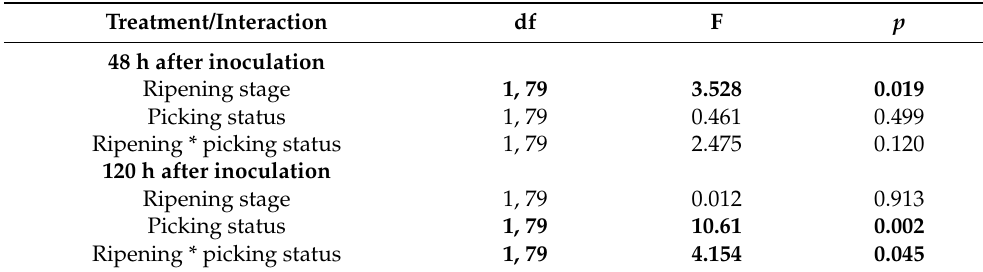
Figure 2. Mean ( ± 1 SE) Bactrocera tryoni larval survival in tomato fruit at two ripening stages (colour break and fully ripe) and of two different picking states (unpicked or picked), at 48 h and 120 h after larval inoculation (starting n = 40 for each ripening × picking status treatment). Each time point includes the fruit picking state compared for each ripening stage (columns surmounted by the same lower-case letter are not significantly different at p = 0.05); fruit ripening stage compared within the picking state (columns surmounted by the same upper-case are not significantly different at p = 0.05). Table 3. Two-way analysis of variance results for Bactrocera tryoni larval survival in tomato fruit of two ripening stages (colour break and fully ripe) and two picking states (picked or unpicked). Separate ANOVAs are presented for the fruits that were destructively sampled 48 and 120 h after larval